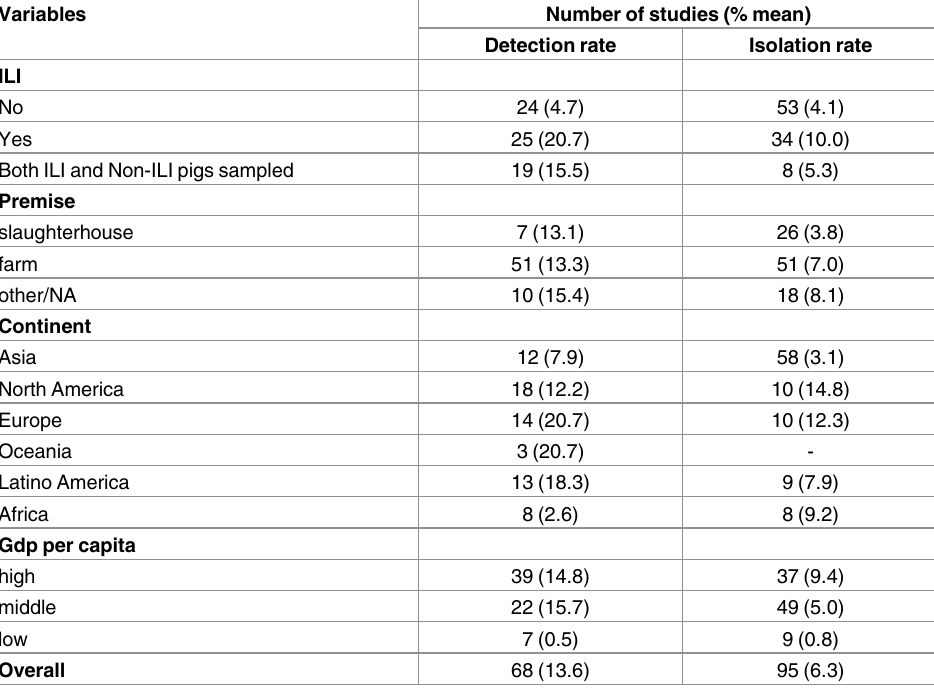
Table 6. Number of studies and means of detection and isolation rates for different variables (out- breaks are